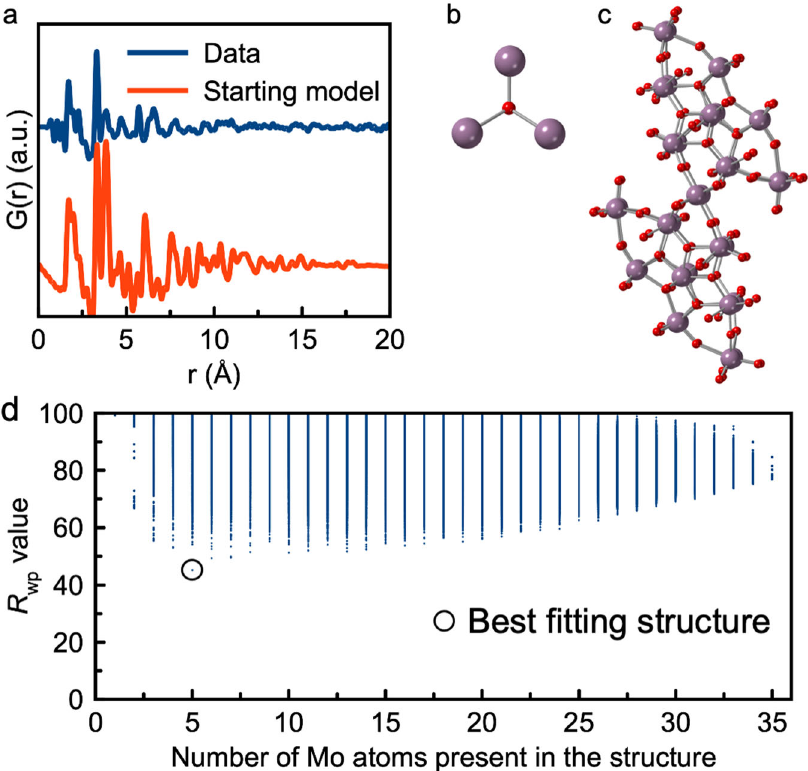
Fig. 6 Analysis of experimental PDF from disordered molybdenum oxide. a Comparison of experimental PDF from a disordered molybenum oxide 7 , and simulated data from Mo 36 O 128 cluster, used as starting model. The simulation parameters mimic typical values of a PDF dataset and can be seen in Supplementary Table 3. b Structure of the Mo 36 O 128 cluster. c R wp values obtained in the fi ts using the Mo 36 O 128 structure catalogue, plotted as a function of number of atoms in the structure motifs.